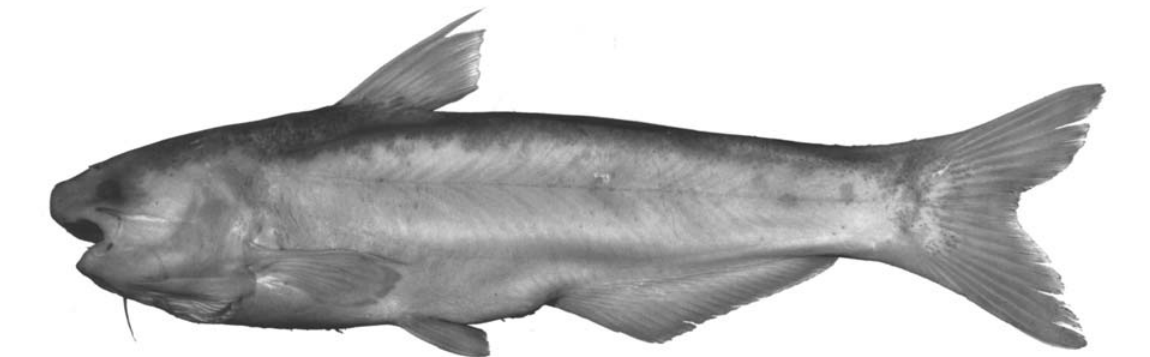
Fig. 22. Cetopsis gobioides, ITAIPU 57, 103 mm SL; Paraguay, upper río Paraná basin, Foz de Iguazu (25°33’S,